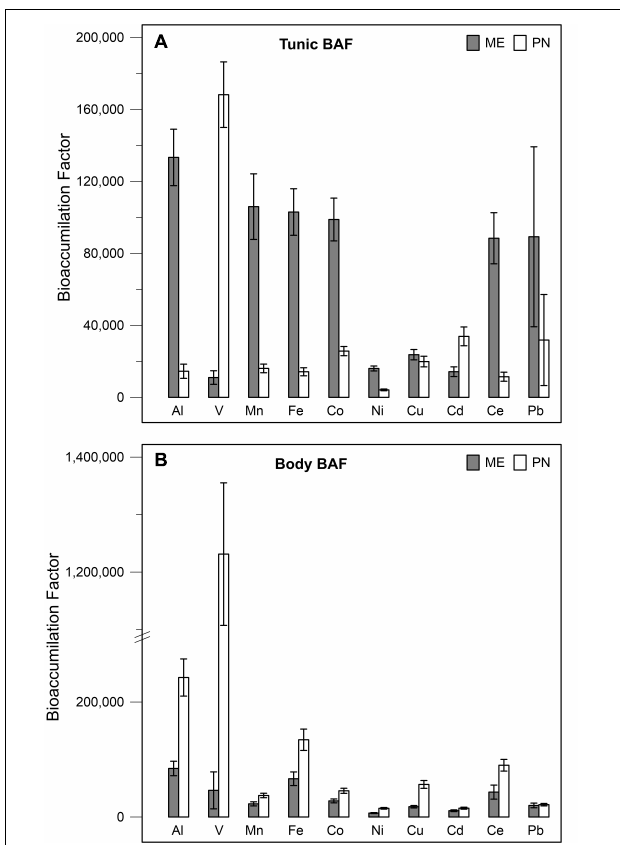
FIGURE 7 | Bio-accumulation factor values of M. exasperatus (mean + SE) and P. nigra (ME, PN), for the different metals as calculated for the tunic (A) and for the body (B) based on samples collected in Akko, Mikhmoret, and Eilat, n = 29 – 43.